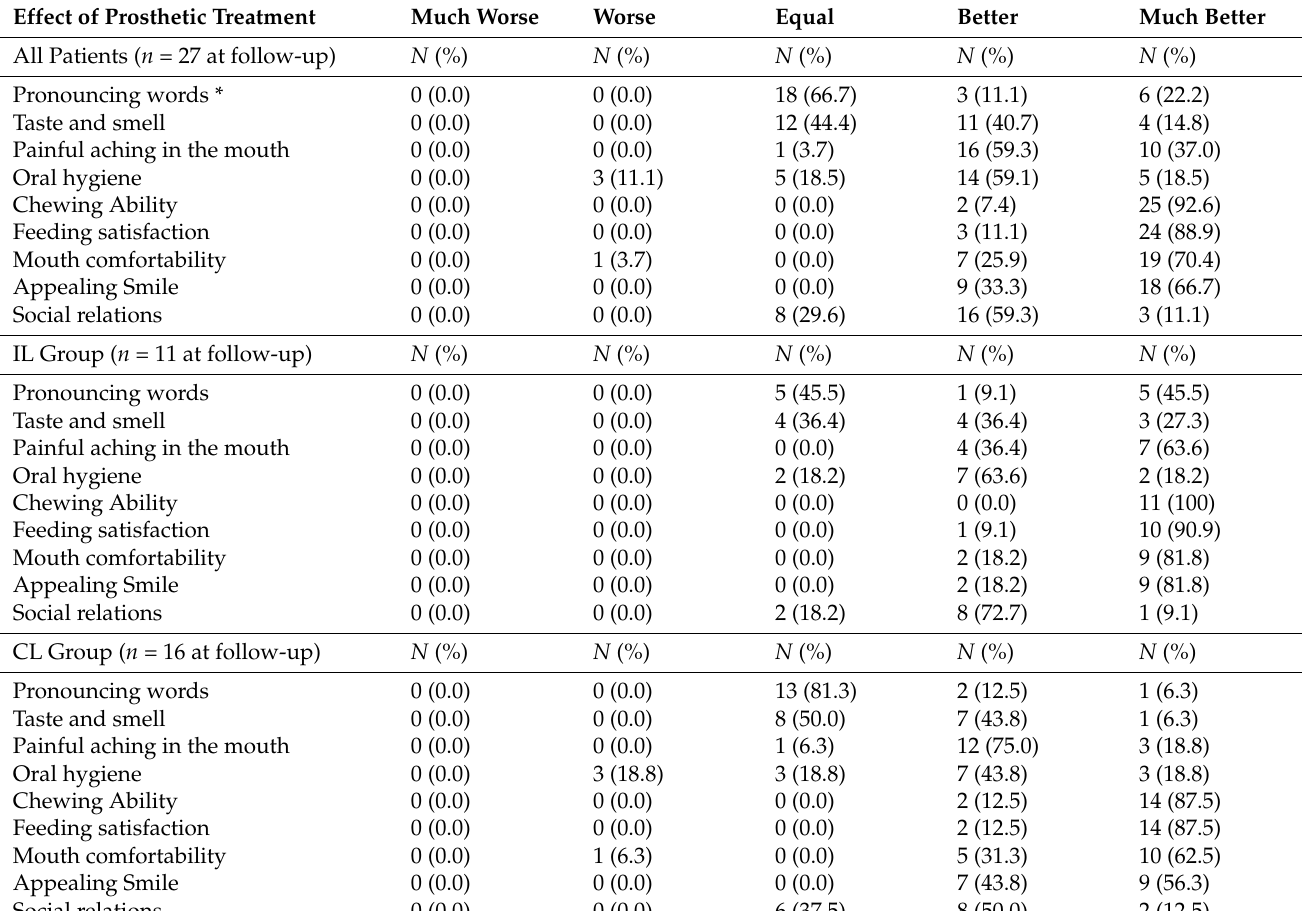
Table 9. Retrospective evaluation of the prosthetic treatments (Hybrid Full-Arch PEEK-NFC) by Global Transition Items in the following sample ( n = 27) and within loading